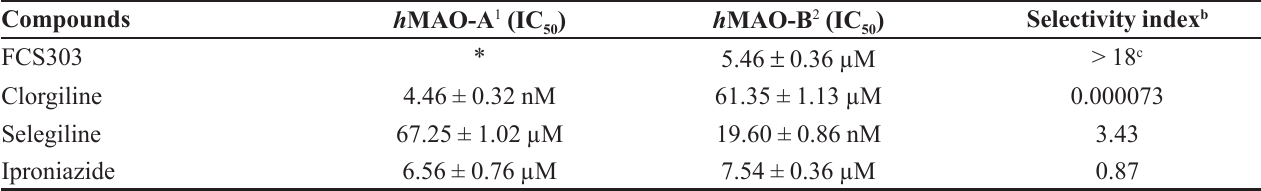
TABLE I - In vitro h MAO-A and h MAO-B inhibitory activities of compound FCS303 and reference compounds a